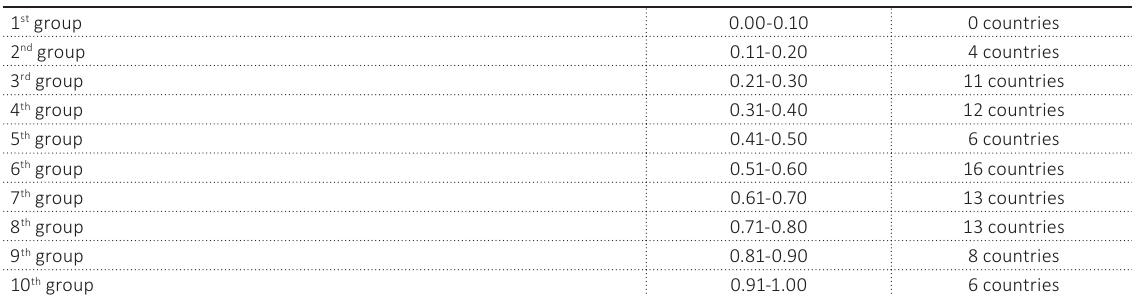
Source: Own research.